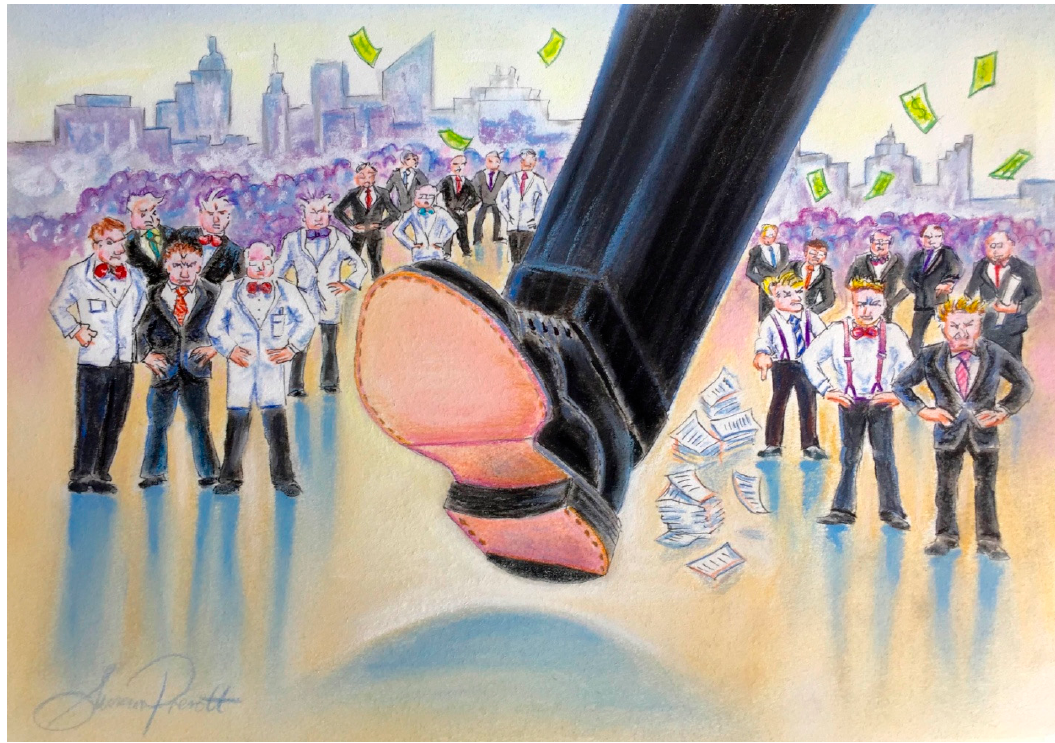
Figure 1. The total lived experience. To what extent does authoritarianism erode trust and compromise shared decision making, cultural competency, understanding values and patient-centered care in the age of non- communicable diseases?